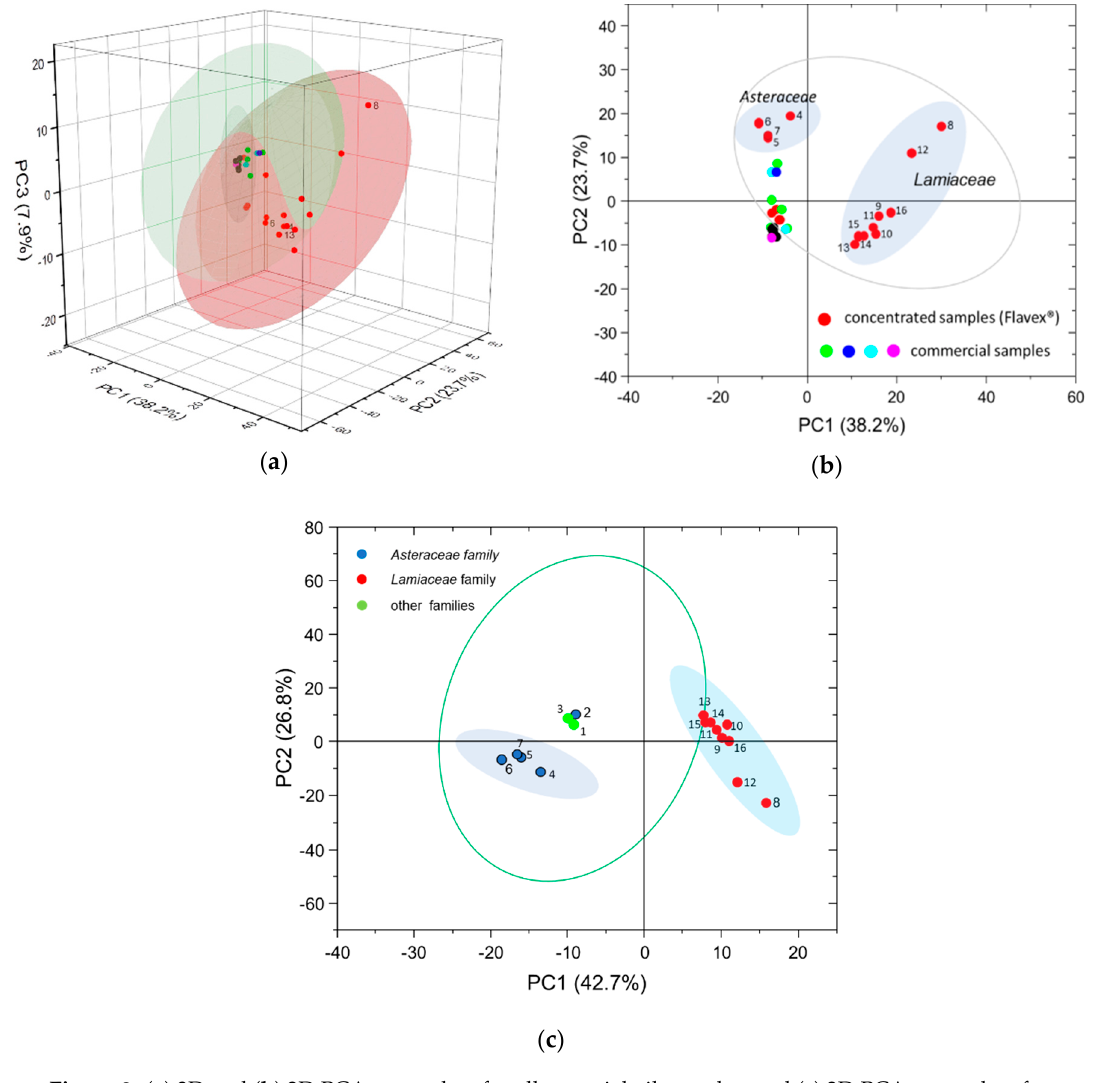
Figure 2. ( a ) 3D and ( b ) 2D PCA score plots for all essential oil samples, and ( c ) 2D PCA score plots for concentrated essential oil samples obtained from FLAVEX ® .